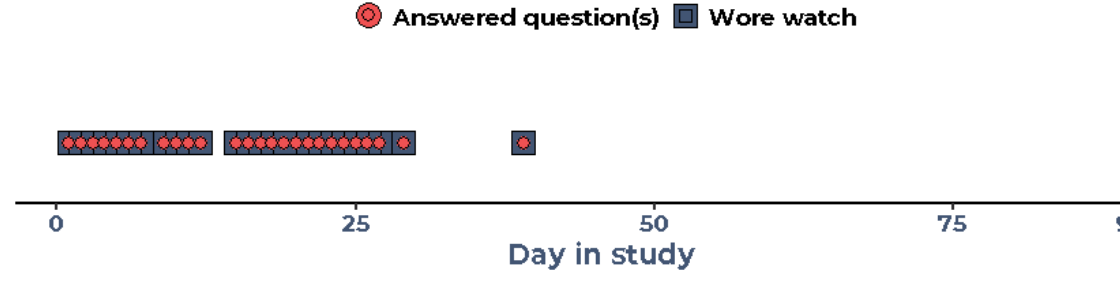
Figure 7. Engagement of case study 2 over 90 study